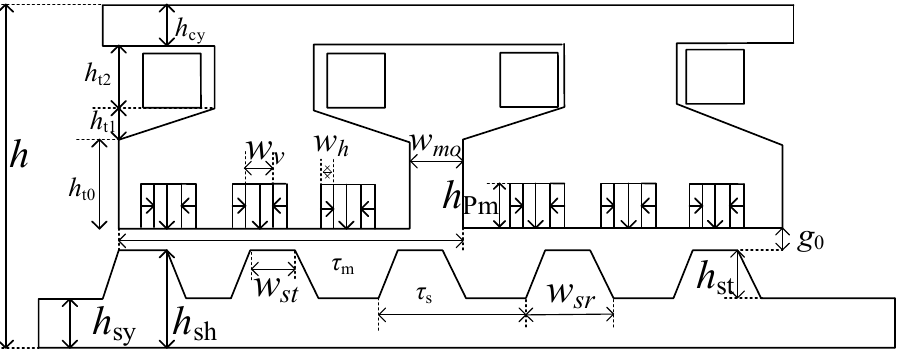
Figure 9. Dimension structure of STMLPMVG.